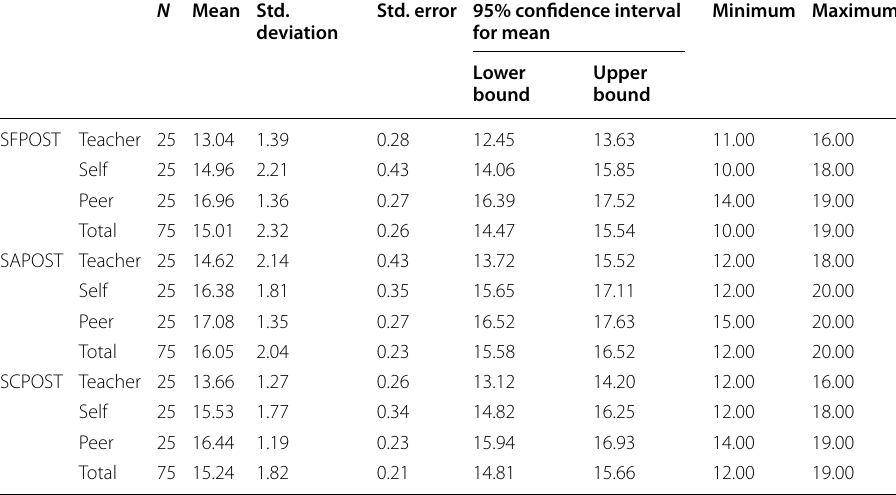
Table 4 Inferential statistics of all groups on the posttests of speaking accuracy, fluency, and complexity